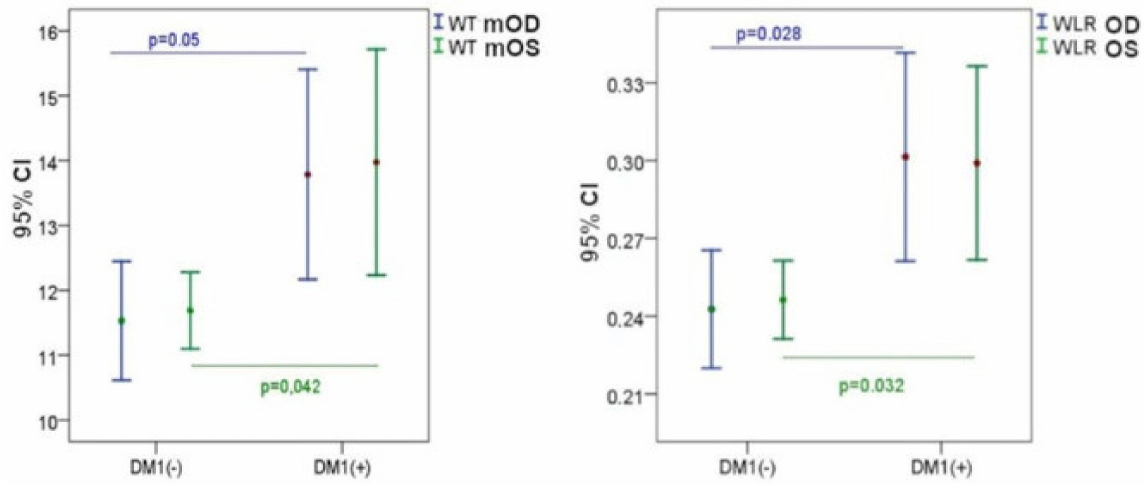
Figure 2. WT and WLR values in the group of DM1 patients (DM1+) and the control group (DM1 − ), left eye (OS), right eye (OD), and confidence interval (CI). In the DM1 group, WT, WLR, and WCSA correlated significantly ( p < 0.05) with the diabetes duration but not with IOP. The correlations of WRL with the diabetes duration are shown in the figure below (Figure